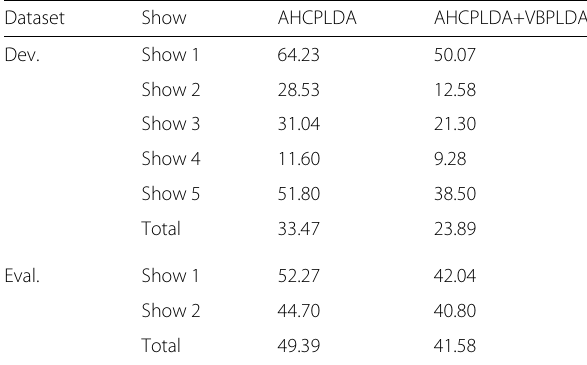
Table 2 DER (%) results per show with baseline system Dataset